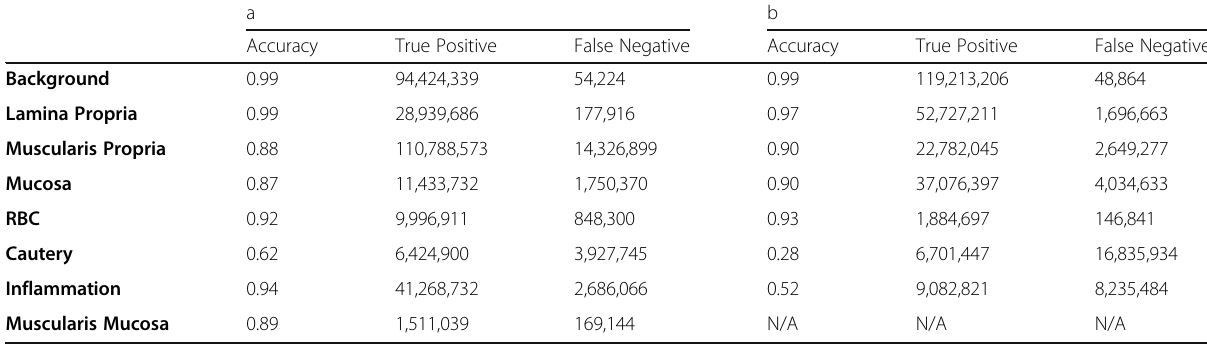
Table 2 Results (pixel level accuracy) on 8 layered U-Net architecture initialized using He Normal. a) Results on the validation